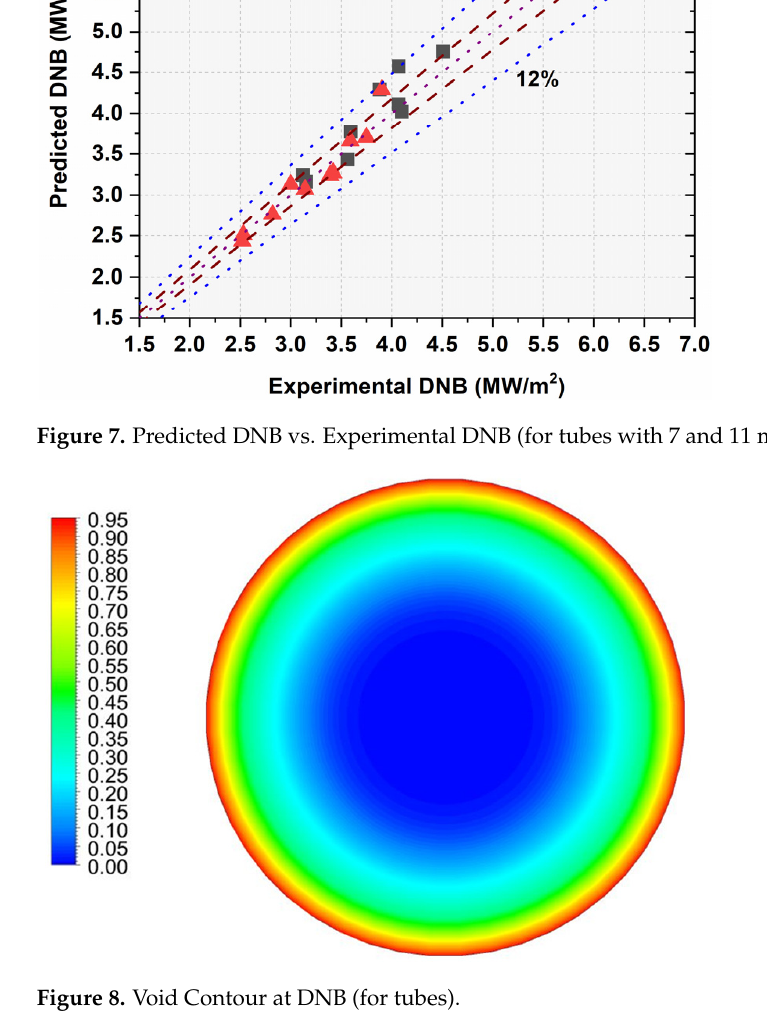
Table 6. Comparison of experimental data and predicted DNB data.